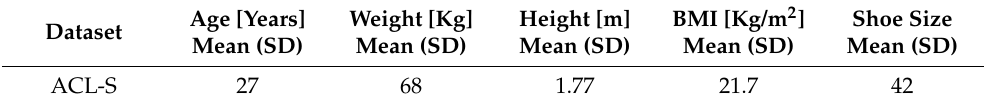
Table A1. Demographic data of the